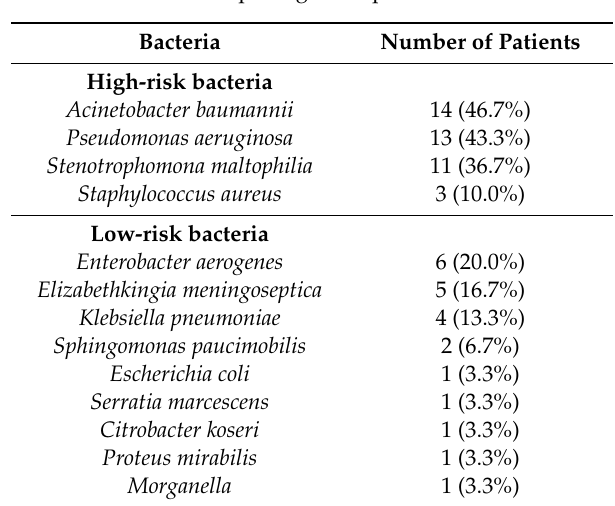
Figure 1. Scatter plots of respiratory data in 30 patients with VAP and 12 non-VAP subjects. ( A ) Hypoxemia score (the ratio of arterial oxygen partial pressure to fractional inspired oxygen; PaO2 / FiO2) and ( B ) oxygenation index (OI = FiO2 × mean airway pressure / PaO2) in VAP patients and non-VAP patients (circle). Each dot represents a single patient. The solid lines mark the mean values. ** p < 0.01, *** p < 0.001 by Mann–Whitney U test. Table 3. Isolated pathogens in patients with